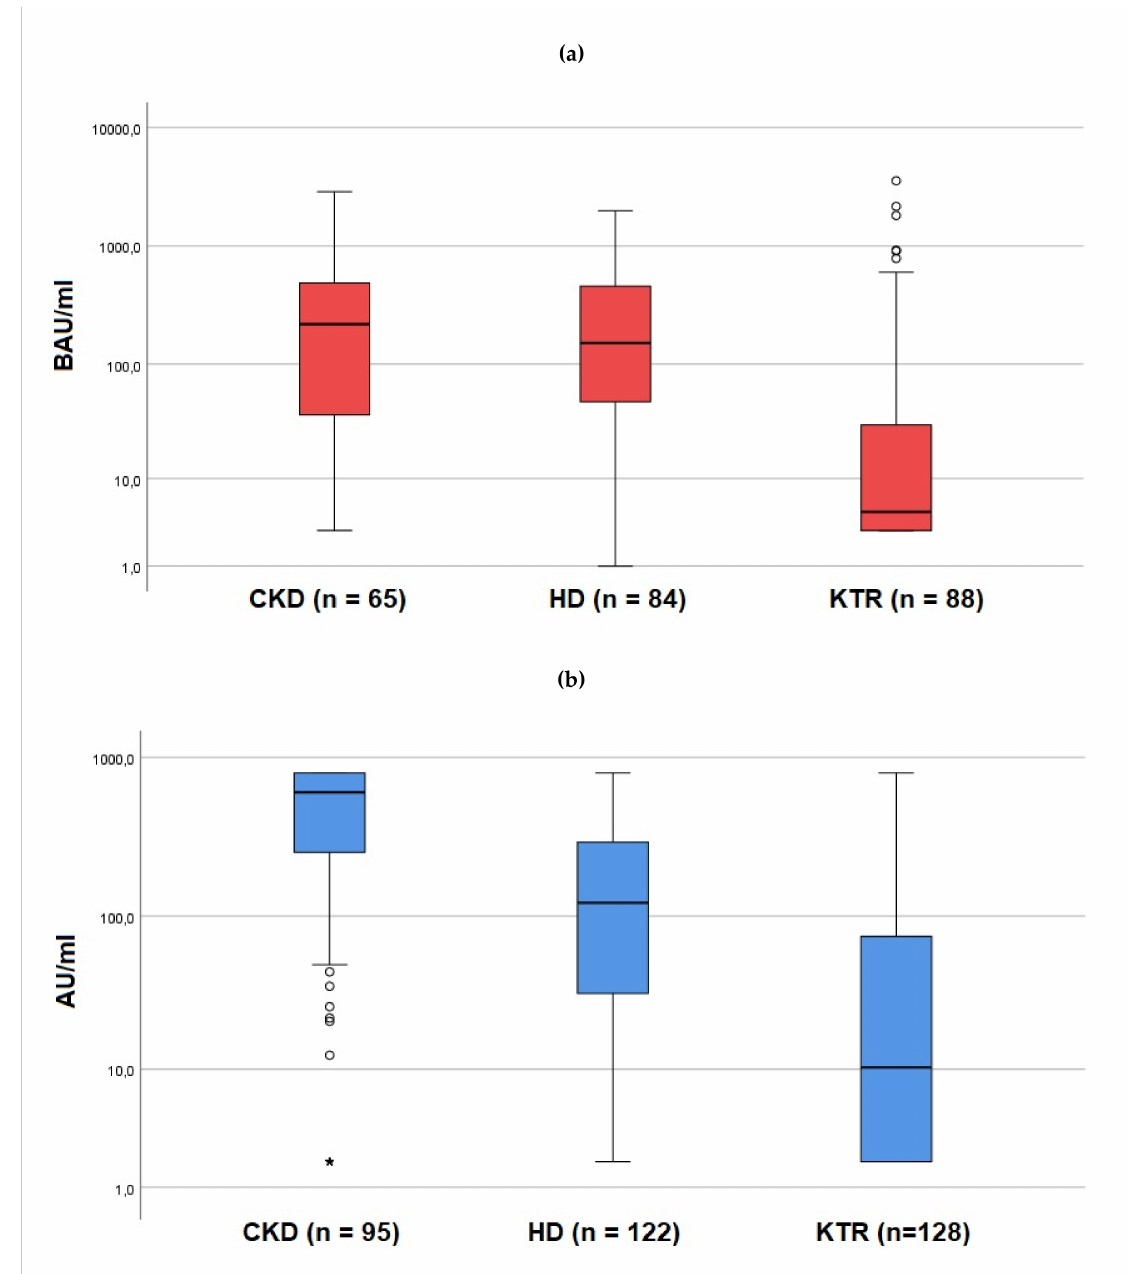
Figure 1. ( a , b ): Levels of antibody titers in CKD patients, HD patients, and KTR. ( a ) shows the results of the Abbott SARS-CoV-2 IgG II Quant Assay test (median, 25, and 75% percentile for CKD: 230.3 (48.3–497.6), for HD: 151.6 (47.7–458.4), for KTR: 4.8 (3.0–30.2); ( b ) shows the results of the Liaison ® SARS-CoV-2 S1/S2 IgG test (median, 25, and 75% percentile for CKD: 602.0 (252.5–800.0), for HD: 121.5 (32.0–293.0), for KTR: 10.3 (1.9–74.3). Logarithmic scale. Circles represent statistical outliers between 1.5 to 3.0 times of the interquartile range (IQR), asterisks represent statistical outliers more than 3 times of the